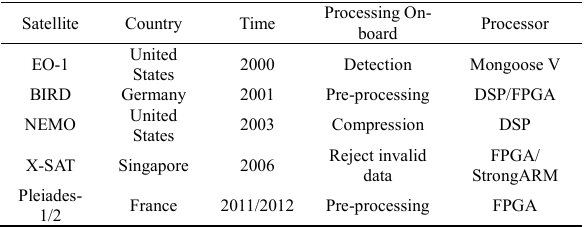
Table 1. Application of processing on-board of remote sensing